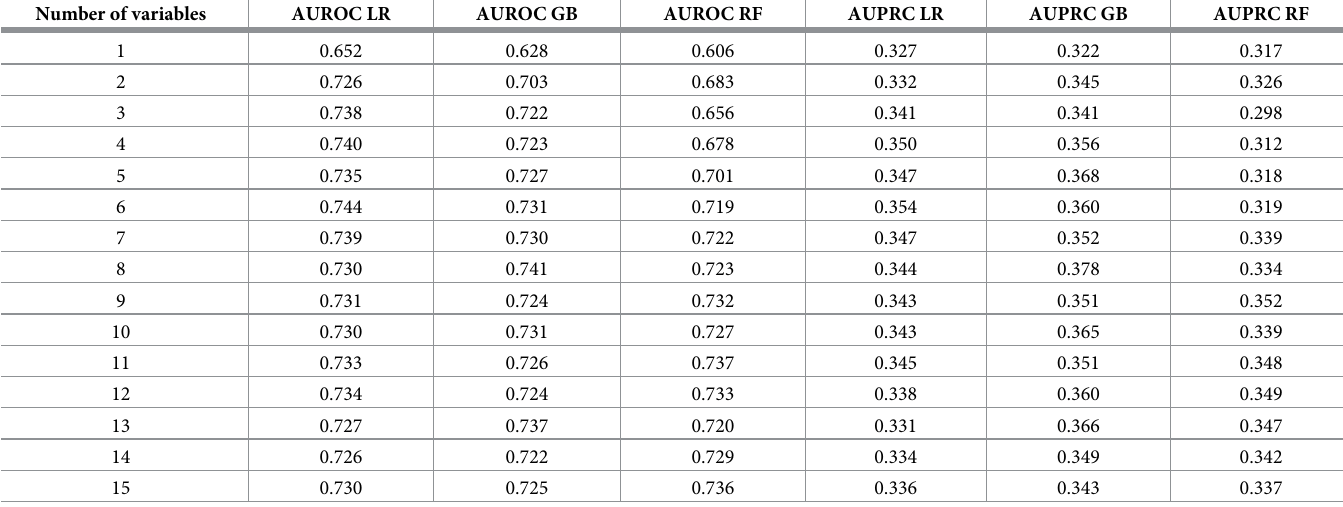
Table 4. AUROC and AUPRC values as a function of the number of variables for predicting revision ESS. We selected variables using the sequential forward selection (SFS) method. Three models were used and the classifiers in these models were the logistic regression (LR), gradient boosting (GB) and random forest (RF) for predicting revision ESS. Table 4 (AUROC values) is related to Fig 4.